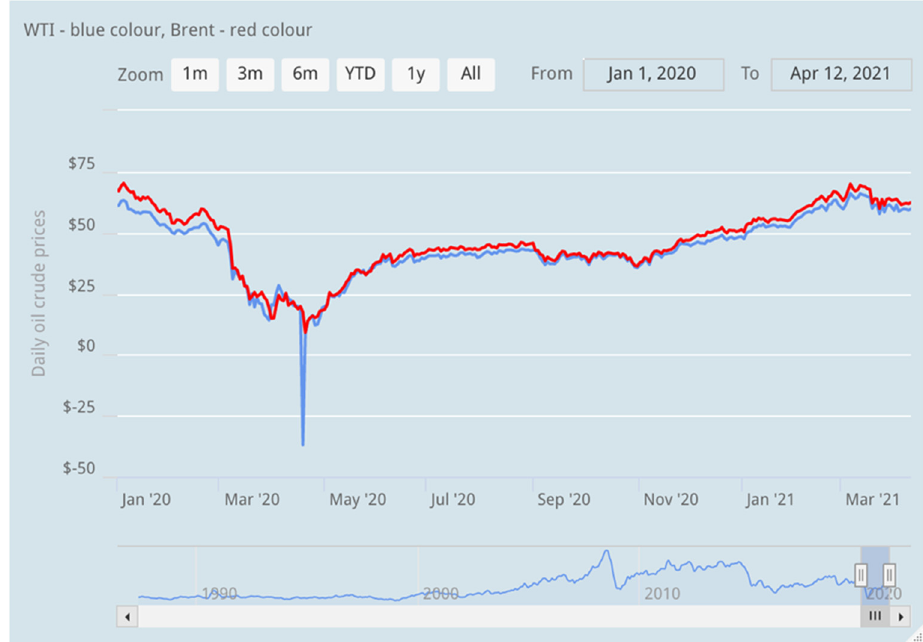
Figure 1. Spot Prices (Crude Oil in Dollars per Barrel) during the pandemic period (January 2020– March 2021). Source of data: U.S. Energy Information Administration, Crude Oil Prices: West Texas Intermediate (WTI)—Cushing, Oklahoma and Europe Brent, retrieved from FRED, Federal Reserve Bank of St. Louis; Author’s representation.